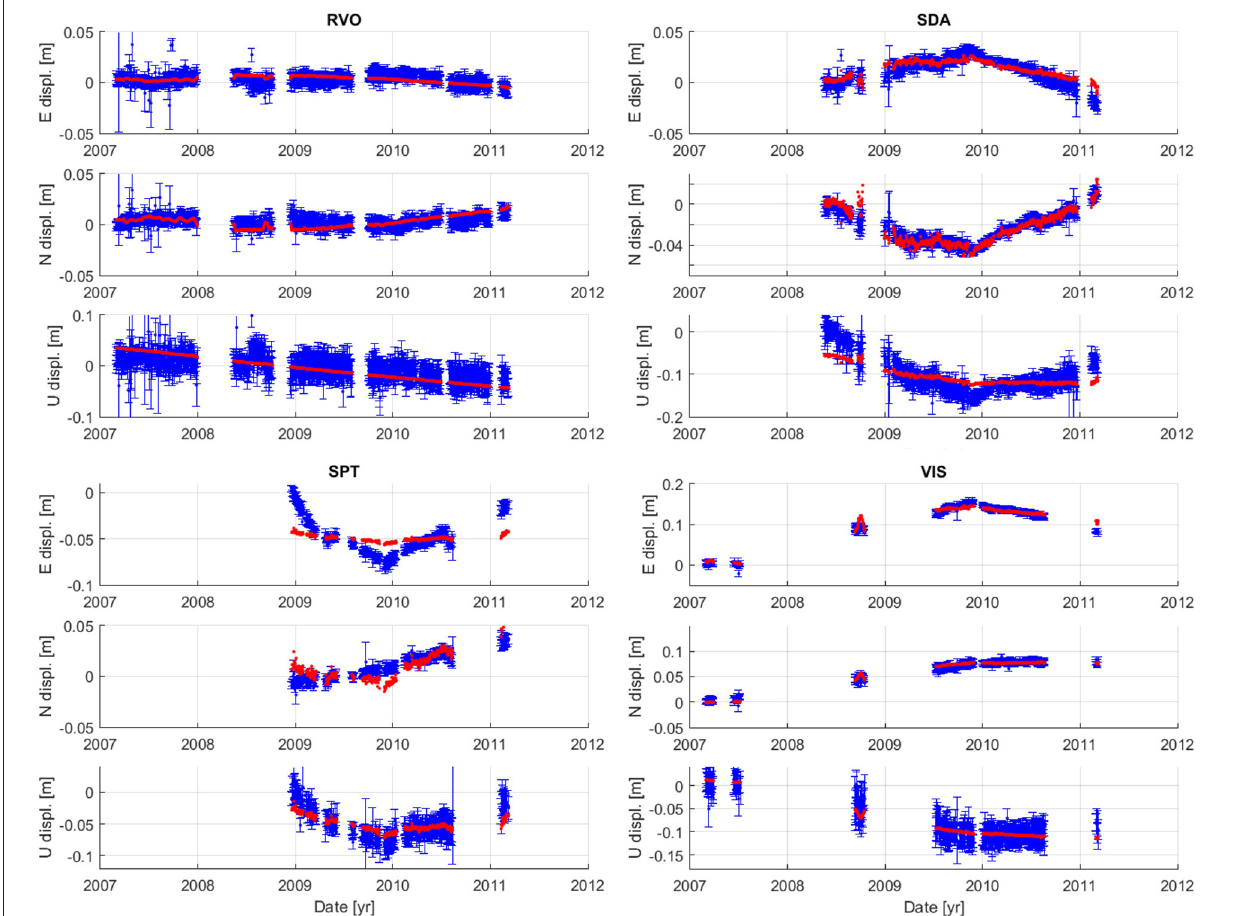
FIGURE 9 | GNSS data and model predictions determined by the joint inversion time series (Step 2). Blue points with error bars show the GNSS observations and red line shows the model prediction of a single Mogi source at the location with minimum wRMS identified by the joint grid search (Step